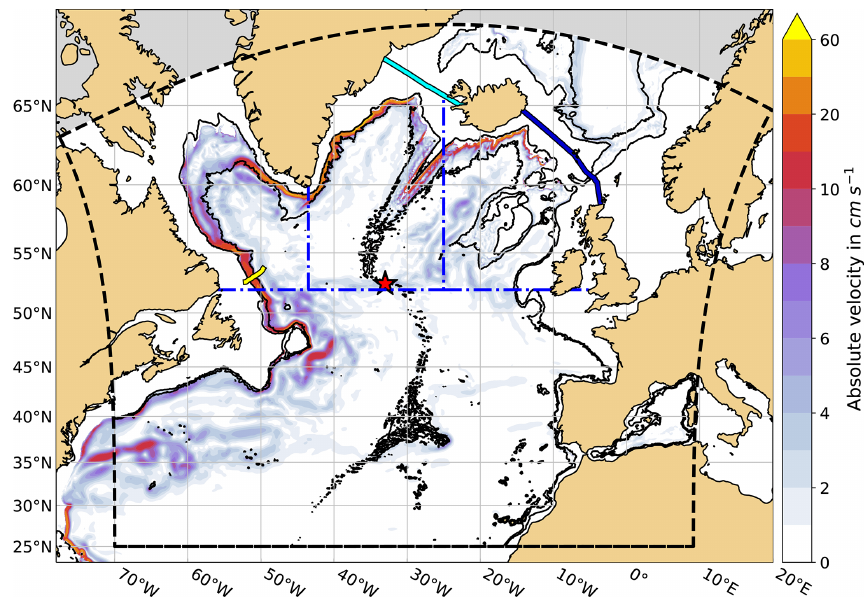
Figure 1. Mean absolute velocity (1958–2019, in cms − 1 , shading) at 1298m in VIKING20X-JRA-OMIP. The Charlie–Gibbs Fracture Zone is indicated by the red star. The yellow line marks the 53 ◦ N section, and the light and dark blue lines mark the Denmark Strait and Iceland– Scotland Ridge sections, respectively. The dashed black line indicates the boundary of the experiment domain considered in this study. The dashed–dotted blue lines indicate the areas that are used to calculate the Labrador Sea (west of 43.5 ◦ W; north of 52 ◦ N), the Irminger Sea (43.5 to 25 ◦ W; north of 52 ◦ N, south of the GSR), the Iceland Basin (east of 25 ◦ W; north of 52 ◦ N, south of the GSR) and southern SPNA (south of 52 ◦ N) volume transport contributions. The black contours indicate the 1000 and 3000m isobaths, respectively, in the Labrador Sea area, as indicated by the dashed–dotted blue lines. In the remaining SPNA the black contours indicate the 1000 and 2000m isobaths,